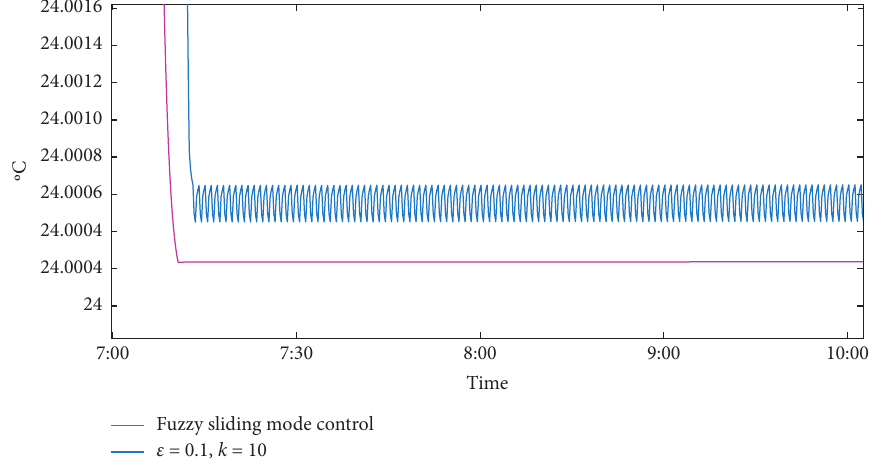
Figure 13: Local temperature response curve after fuzzy control.